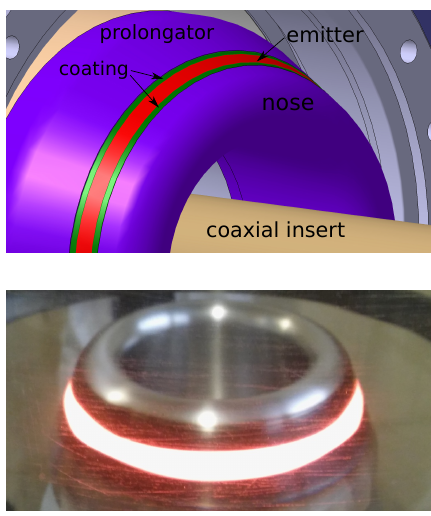
Figure 4. A three-dimensional drawing and a photo of the cath- ode of the new MIG with the emitter ring with the coated edge